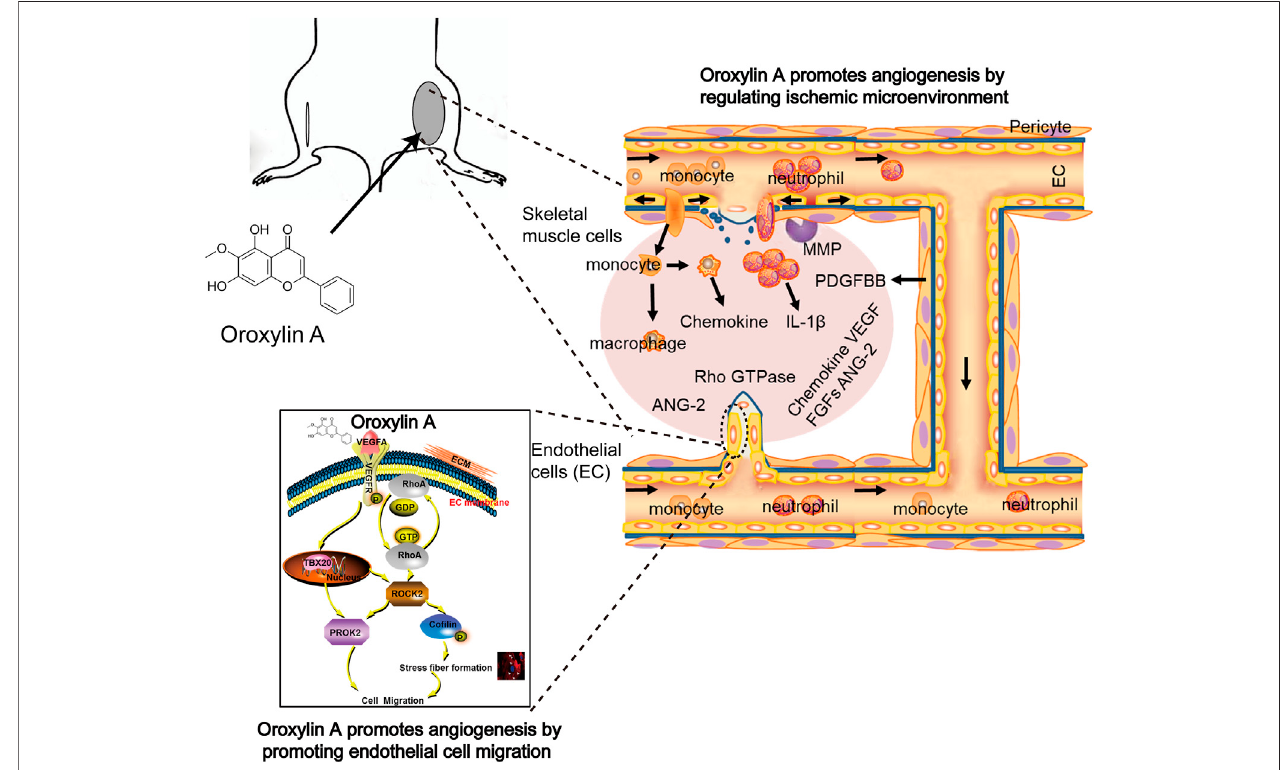
FIGURE 7 | OA increased angiogenesis through multiple mechanisms involving enhanced EC migration, elevated angiogenic factors release, and induced stabilization and growth of blood vessels.